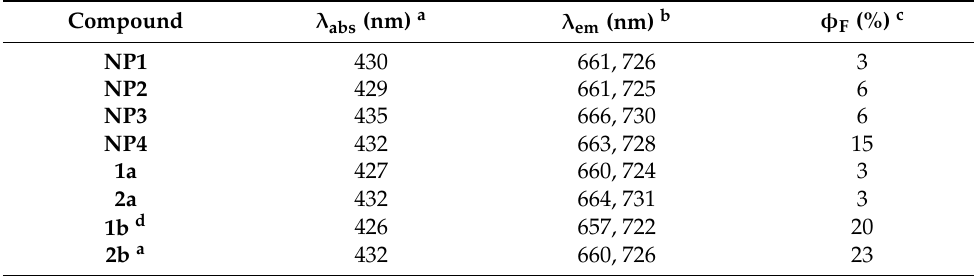
Table 3. Absorption and emission characteristics of porphyrin-loaded NPs vs water-soluble